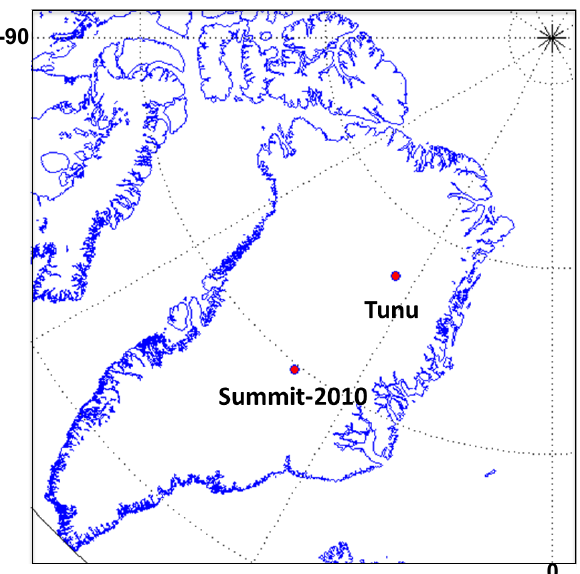
Figure 1. Locations of ice cores used in this study. Summit-2010 (72 ◦ 20 (cid:48) N, 38 ◦ 17 (cid:48) 24 (cid:48)(cid:48) W) and Tunu (78 ◦ 2 (cid:48) 5.5 (cid:48)(cid:48) N, 33 ◦ 52 (cid:48) 48 (cid:48)(cid:48)